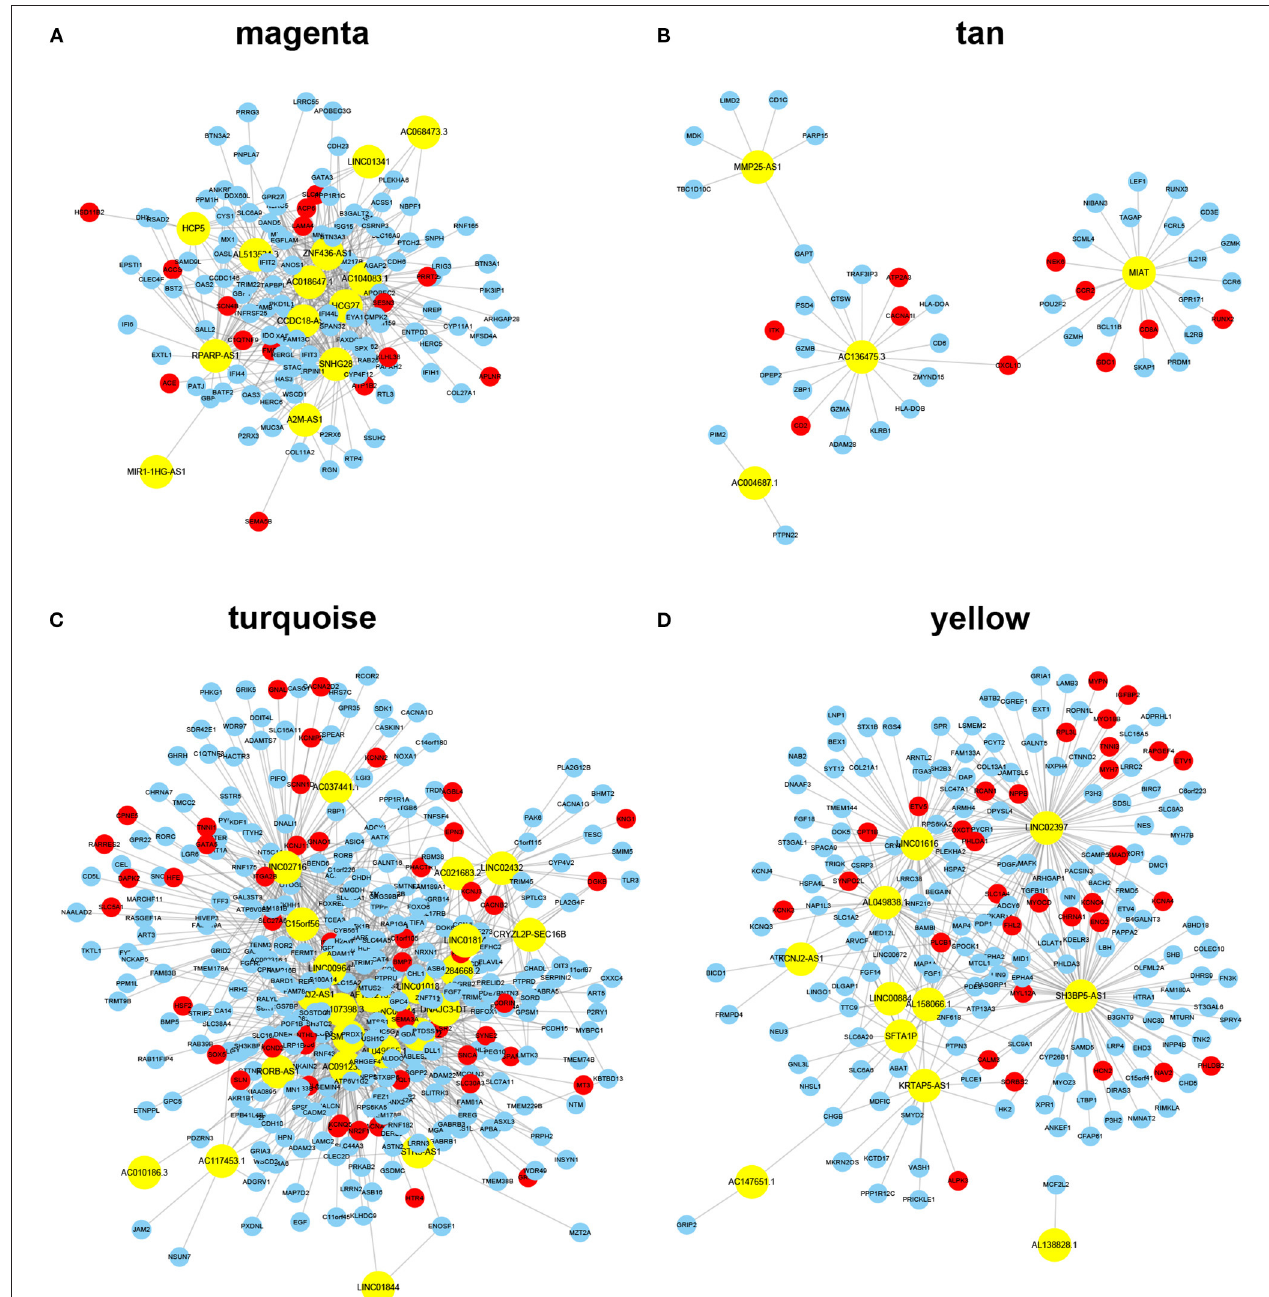
FIGURE 3 | ceRNA networks for each module. Note: the yellow color represents lncRNAs, whereas the red color represents known AF protein-coding genes identified from DISEASE, DisgeNET, and MALACARD databases. (A–D) lncRNA-mRNA ceRNA networks identified using a module-specific manner in AF susceptibility-associated magenta (A) and tan (B) modules, and AF persistence-associated turquoise (C) and yellow (D)